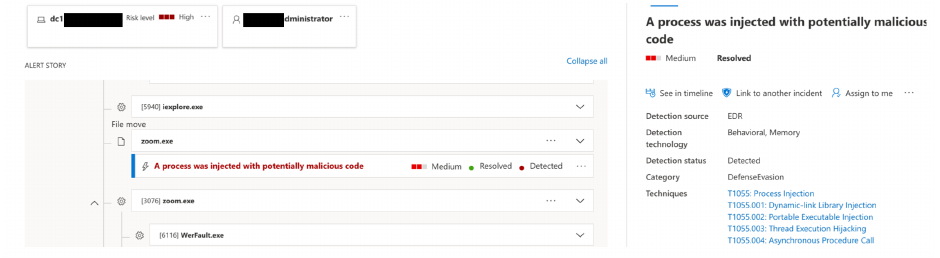
Figure 26. Example of ATP catching the APC Early-Bird injection, although direct syscalls were used.